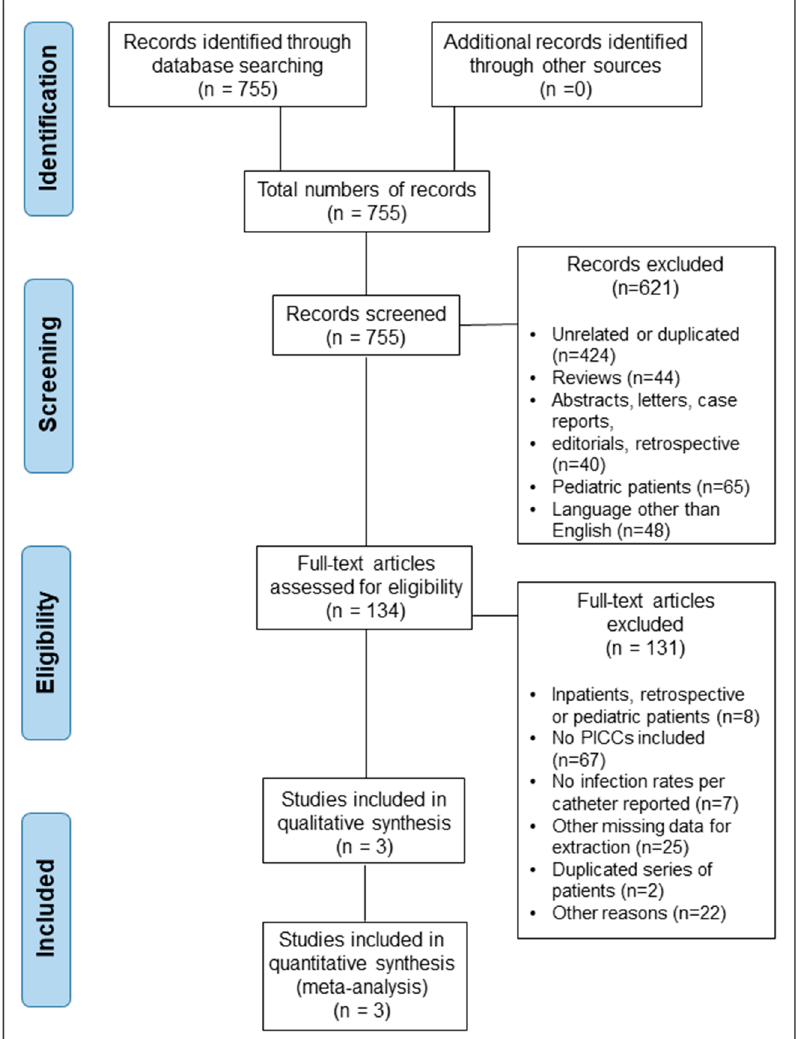
Figure 1. The Preferred Reporting Items for Systematic Reviews and Meta-Analyses (PRISMA) flow diagram.